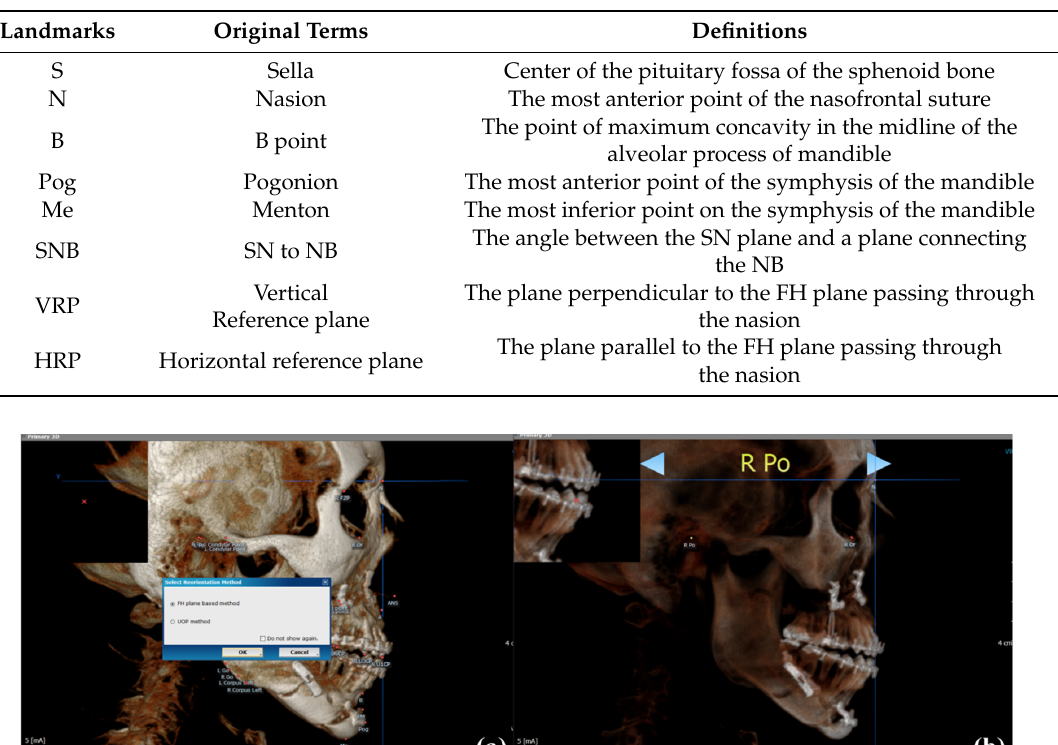
Table 2. Definition of 3D cephalometric landmarks and measurements.